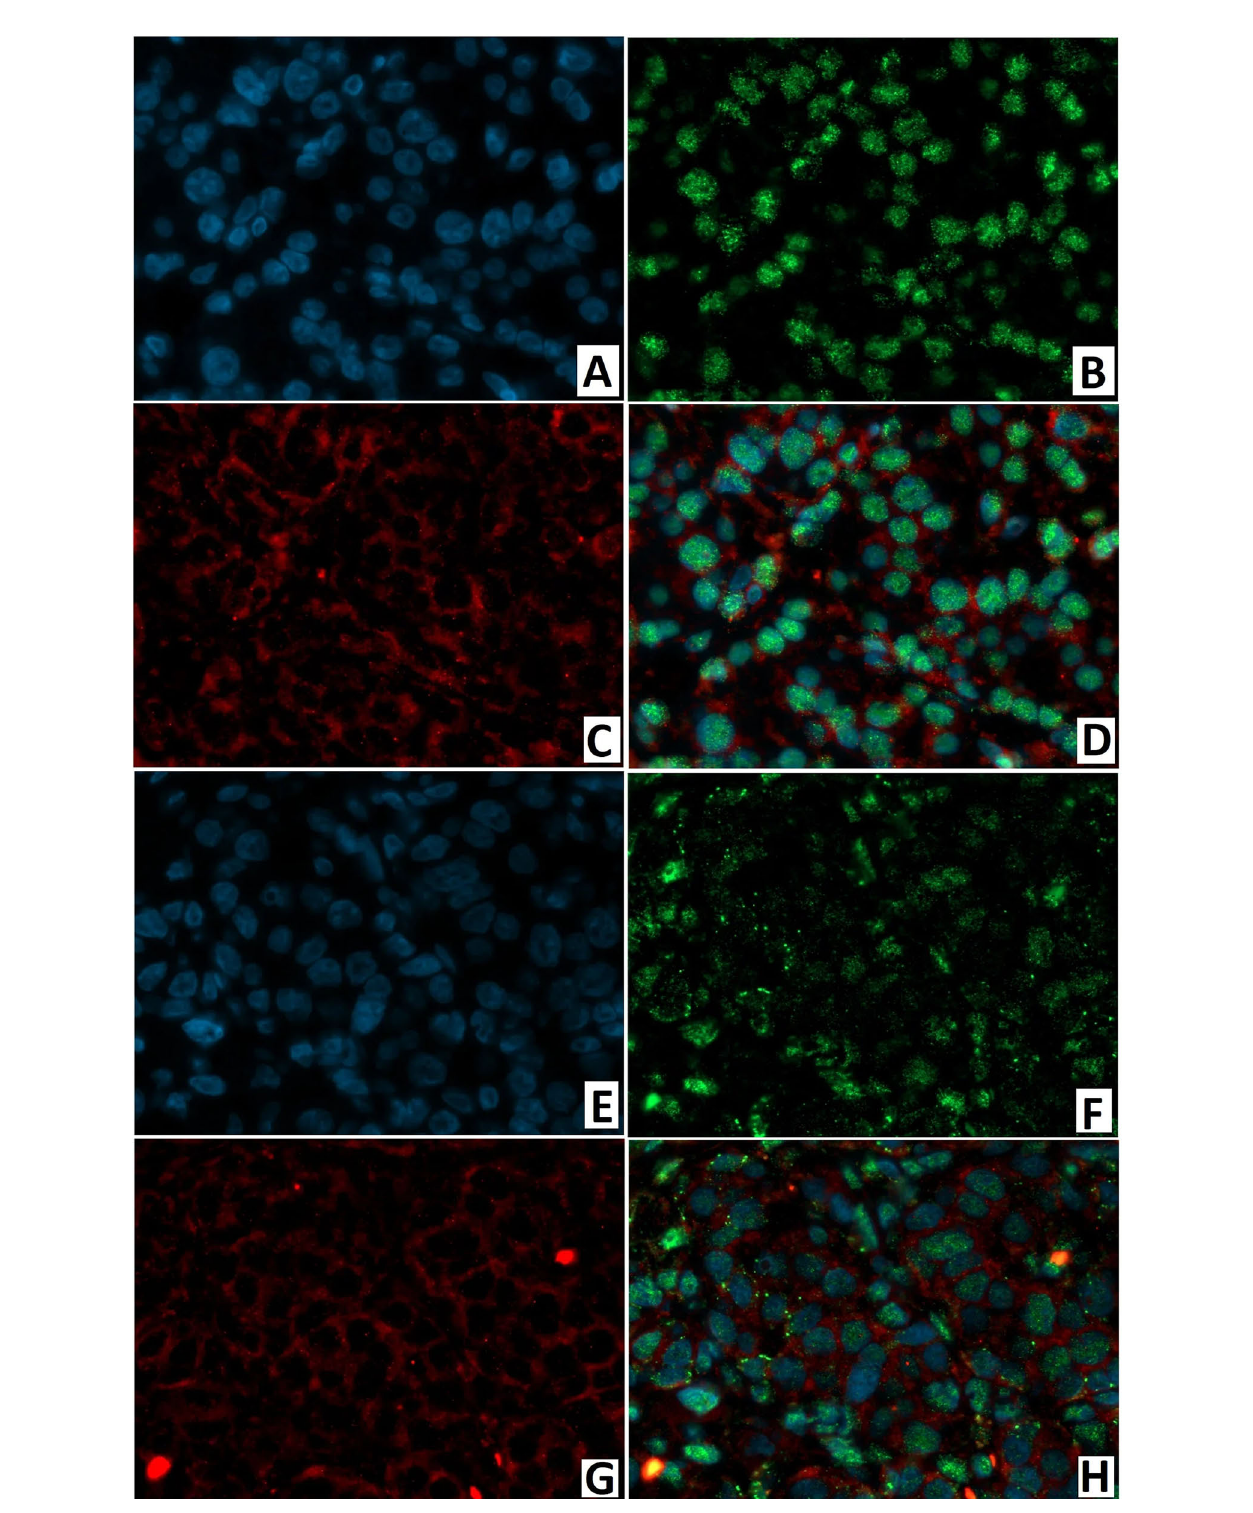
FIGURE 15 | Confocal laser scanning microscopy of the pancreas in congenital hyperinsulinism. (A – D) focal form, (E, F) diffuse form. (A, F) blue fl uorescence of cell nuclei (DAPI). (B, F) green fl uorescence of NeuroD1 in nuclei. (C, G) red fl uorescence of DR2 in cytoplasm. (D, H) greenish-blue/turquoise fl uorescence of NeuroD1 and red fl uorescence of DR2 in the same cells;